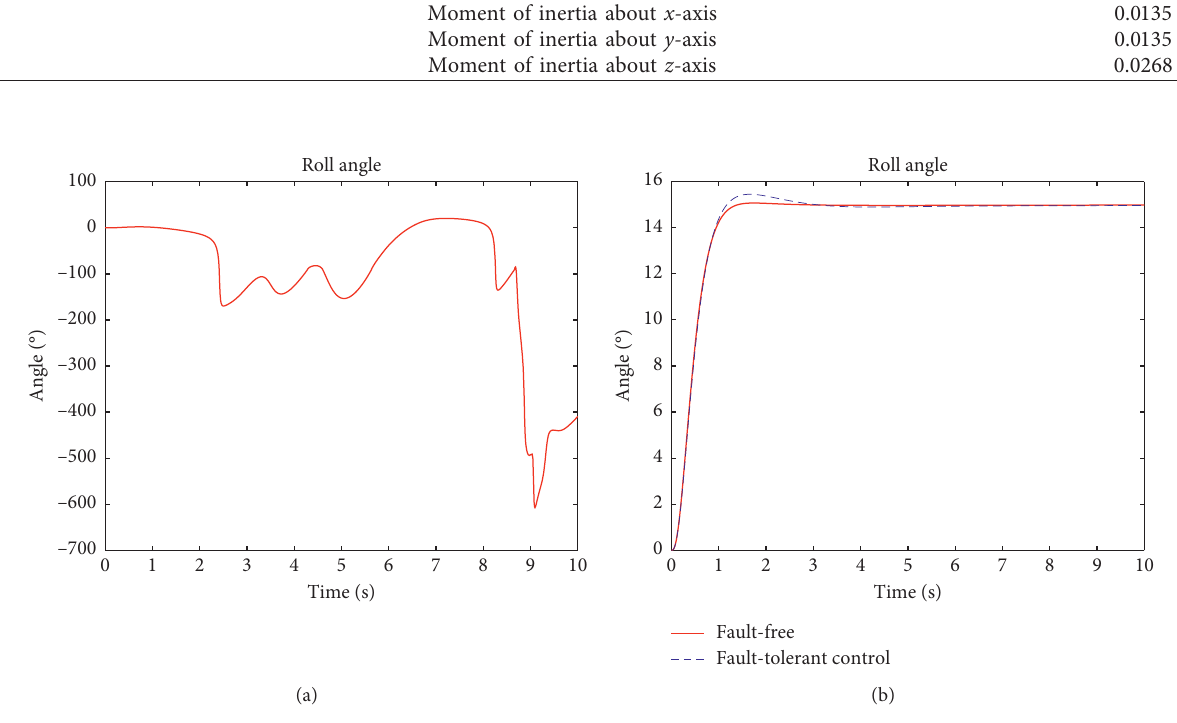
Figure 3: Comparison diagram of the roll angle before and after fault-tolerant control. (a) Non-fault-tolerant control. (b) Fault-tolerant control.